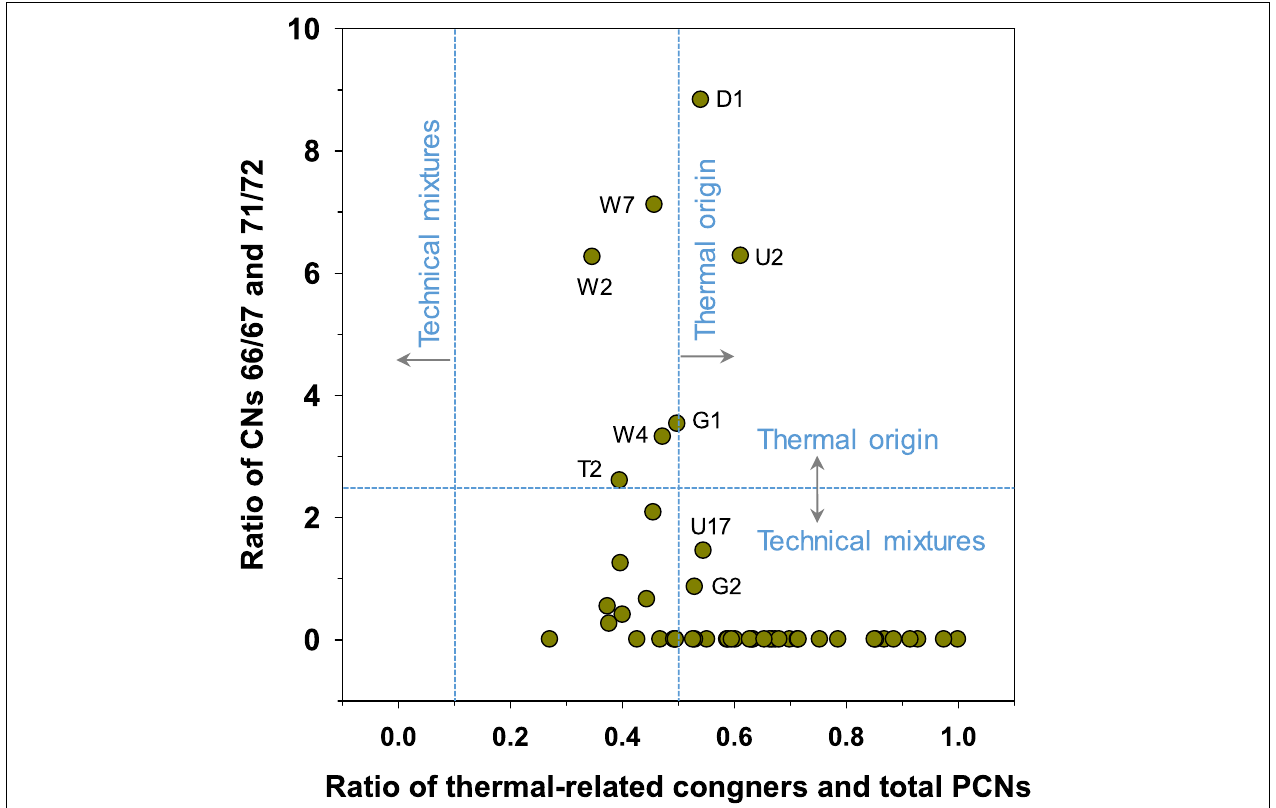
FIGURE 4 | Diagnostic ratios of the concentrations of PCN congeners in sediment from Ulsan and Onsan Bays and their inflowing streams and rivers,